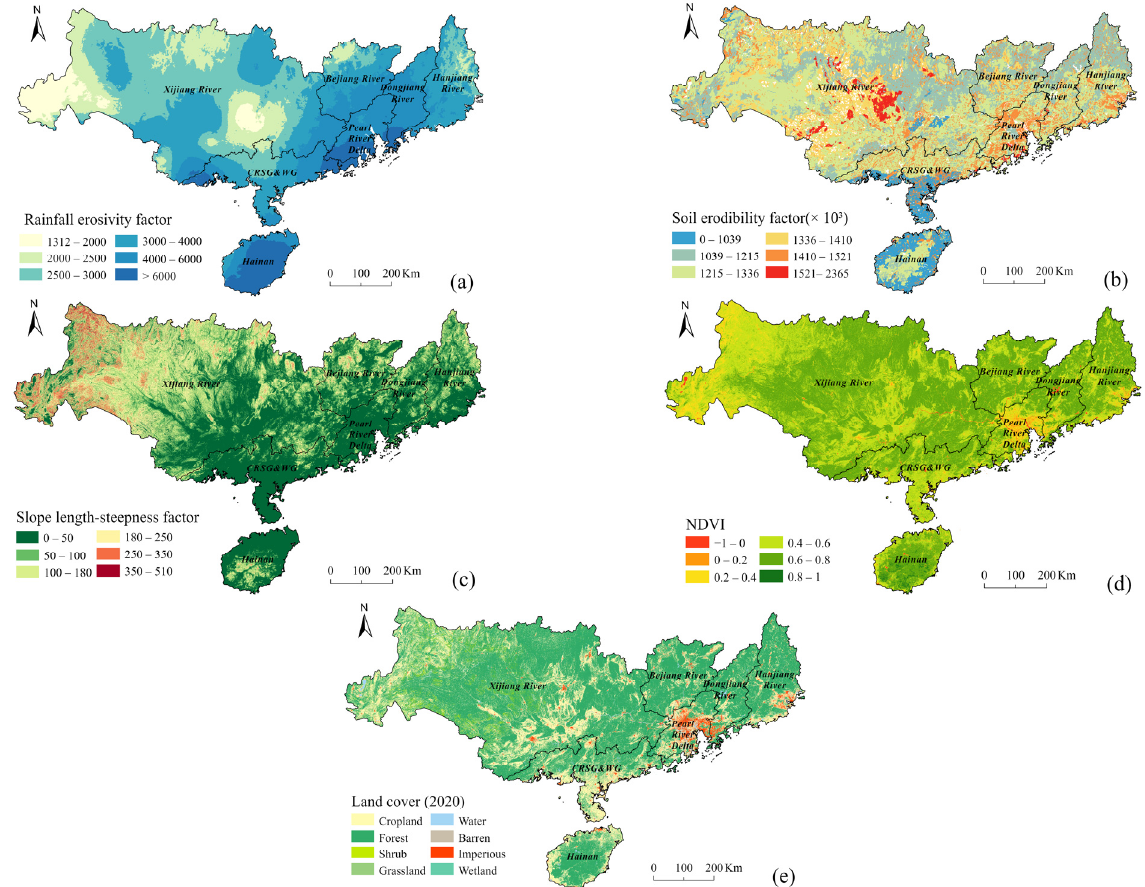
Figure 2. Spatial distribution of factors in the GPRB. ( a ) Rainfall erosivity factor (MJ · mm · hm − 2 · h − 1 · a − 1 ); ( b ) Soil erodibility factor (t · h · MJ − 1 · mm − 1 ); ( c ) slope length-steepness factor; ( d ) 30-year mean NDVI; ( e ) land cover in